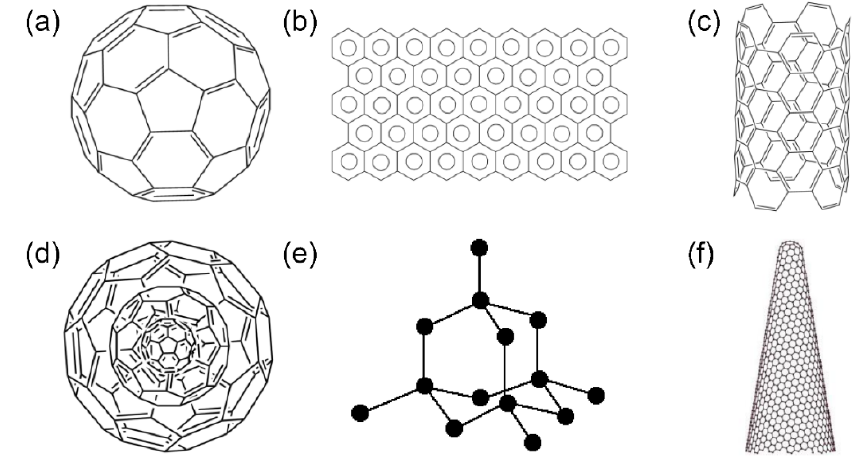
Figure 2. Different types of carbon allotropes crystalline. ( a ) Fullerene—C60, ( b ) graphene monolayer, ( c ) carbon nanotube (CNT), ( d ) carbon nano-onion, ( e ) nanodiamond, ( f ) carbon nanohorn.